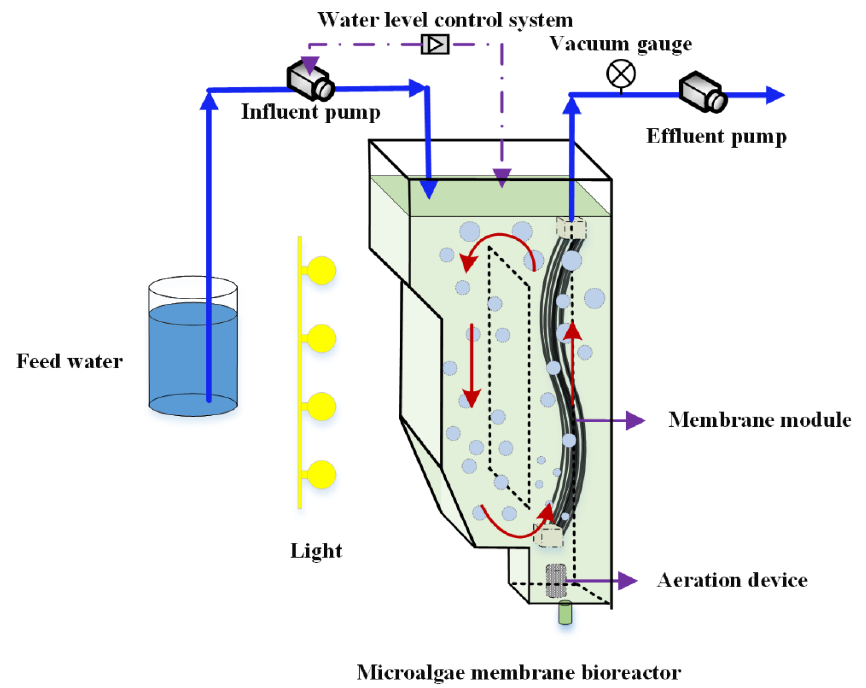
Figure 1. Internal circulating fluidized bed microalgae membrane bioreactor used in the experiment.